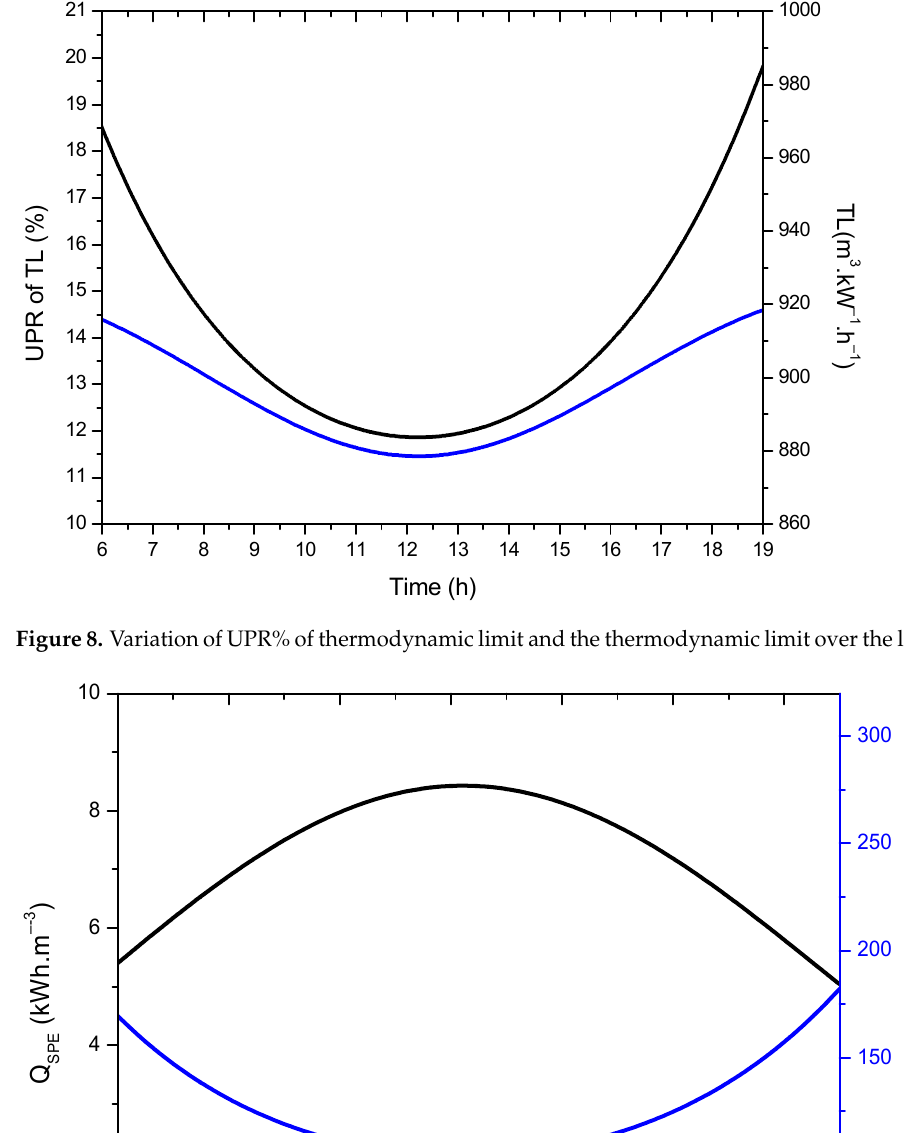
Figure 7. Variation of performance ratio over the local time.